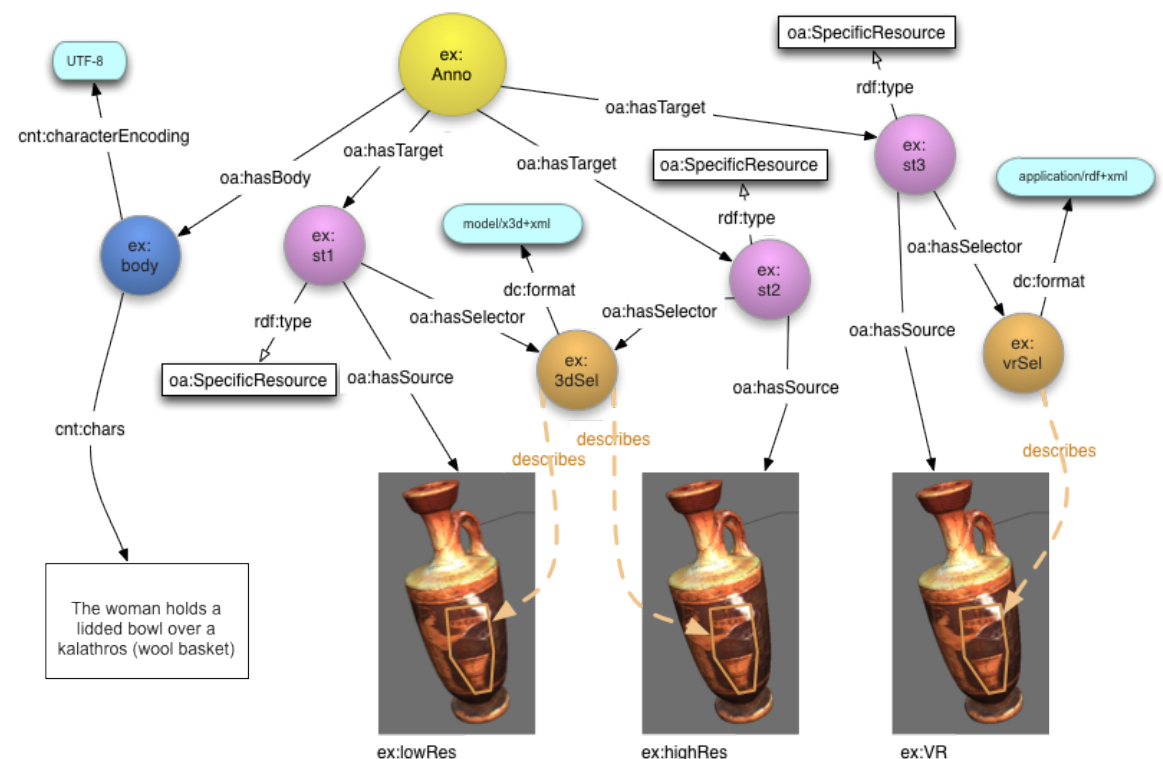
Figure 6. Instance of OA model for